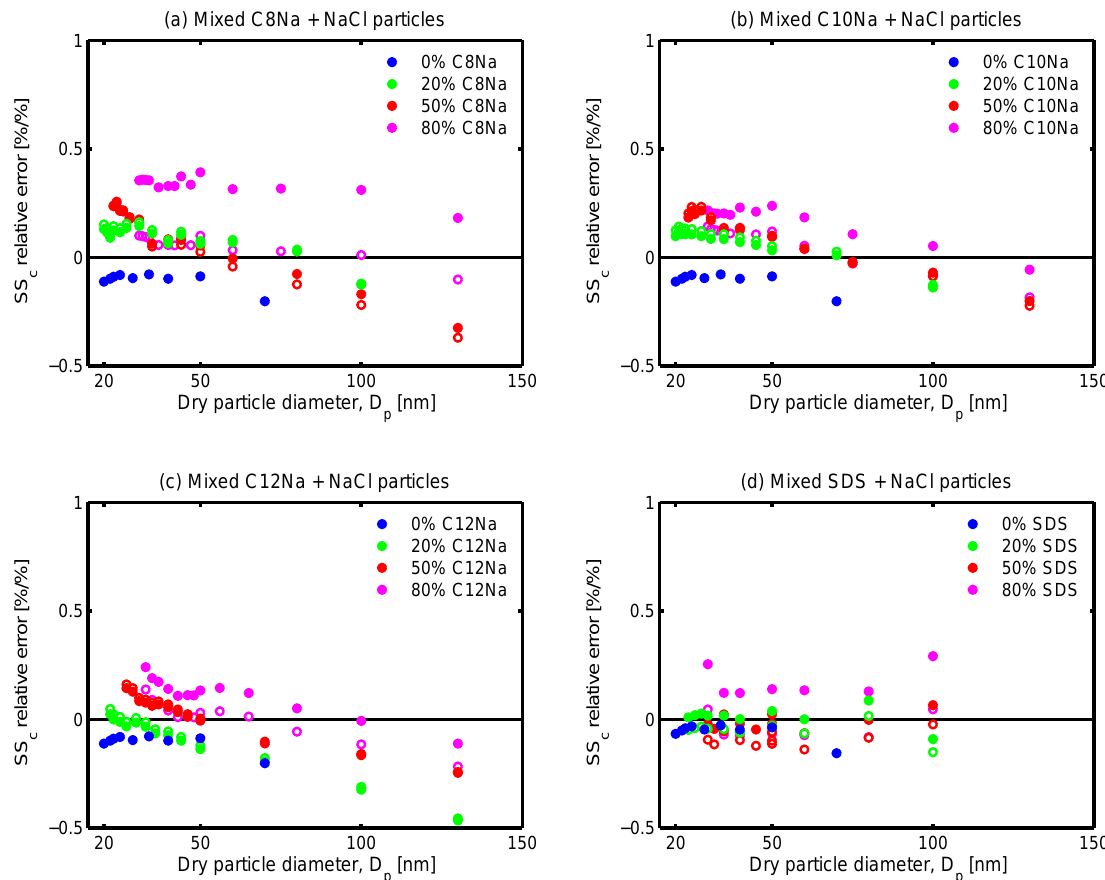
Fig. 6. Relative errors in predicted critical supersaturations ( SS c − SS exp c )/ SS exp c [%/%]) with the detailed thermodynamic model ( σ, p, open symbols) and the simple organic representation (rep1, filled symbols), as functions of dry particle diameter ( D p [nm]), for particles comprising (a) sodium octanoate (C8Na), (b) sodium decanoate (C10Na), (c) sodium dodecanoate (C12Na), and (d) sodium dodecyl sulfate (SDS). Dry particle surfactant mass fractions are indicated by the color of symbols as 0% (blue), 20% (green), 50% (red), and 80% (purple). Results correspond to those shown in Figs. 2, 3, 4, and 5.